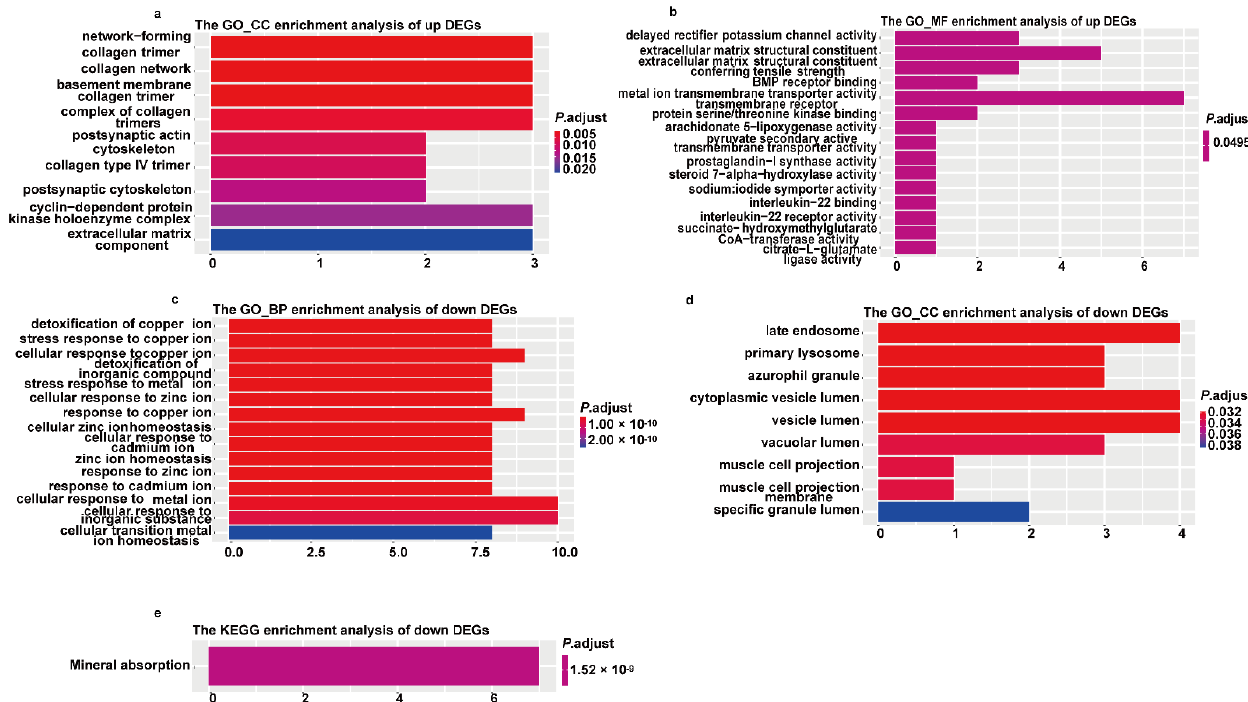
Figure 5. Gene ontologies (GO) analysis of DEGs between Sup-DLBCL and Sub-DLBCL: ( a , b ) cellular component (CC) and molecular function (MF) of gene ontology in upregulated genes; ( c – e ) cellular component (CC) and biological processes (BP) of gene ontology and KEGG for downregulated genes.